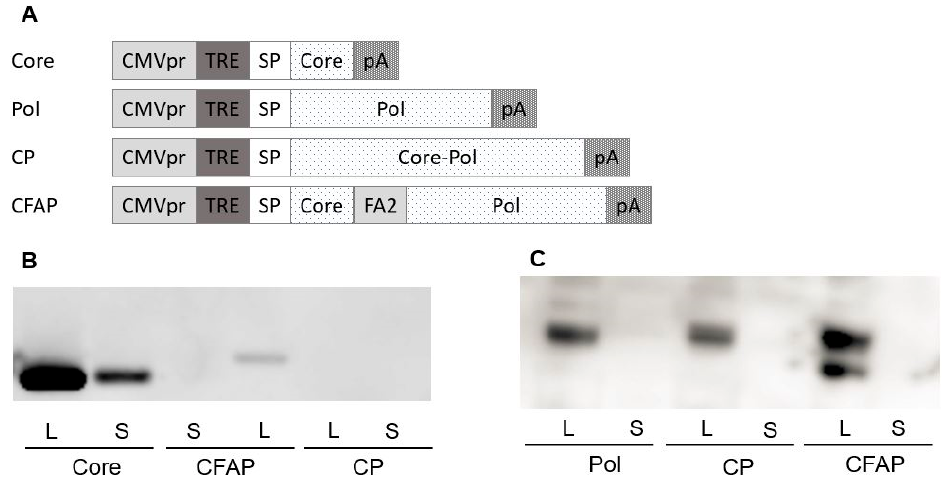
Figure 2. Comparison of Core and Pol expression from different DNA plasmids encoding Core and/or Pol. ( A ) Schematic overview of the different plasmids containing Core and/or Pol evaluated for expression in vitro and in vivo; all plasmids include the CMV promotor, TRE (Triple RNA Enhancer), and signal peptide (SP) upstream of the coding region, which is flanked on the 3 ′ end by a polyA tail. ( B ) Western blot detection of Core protein read out for lysate (L) and supernatant (S) of HEK293T cells transfected with different plasmids shown in Figure 2A (complete figure in Figure S2A). ( C ) Western blot detection of Pol protein in lysate (L) and supernatant (S) of HEK293T cells